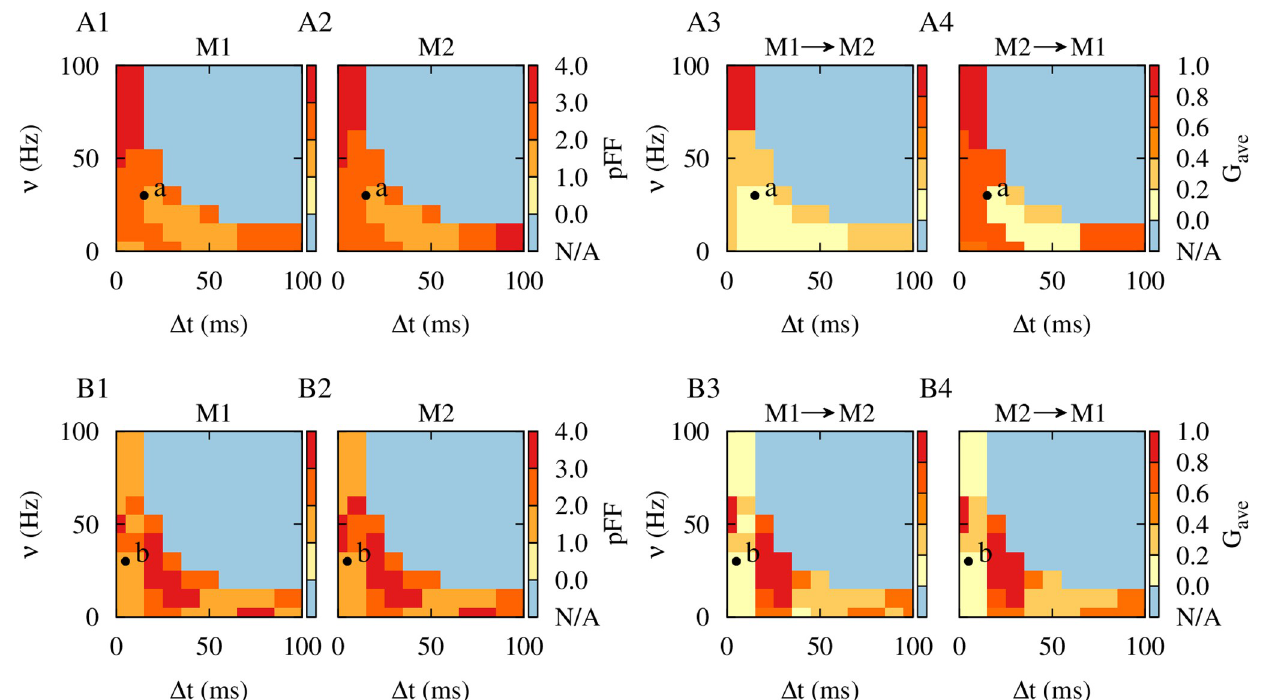
Fig 8. Rescaling the parameters of time-shifted decoupling stimulation. ( A1-A4 ) Synchrony level measured by the pFF of the activity of each module (A1,A2) and the averaged inter-population mean coupling ( G ave ) between the two modules in the network (A3,A4) obtained by numerical simulations for different values of stimulation frequency and time shift with | ξ | = 0.0 ms, evaluated over 10 s of activity after stimulation offset. ( B1-B4 ) Same as A1-A4, but with | ξ | = 10.0 ms. STDP parameters were A + = 0.008, A = 0.005, τ + = 10 ms and τ = 20 ms. Points a and b in the figure indicate the stimulation frequency − − and time shift used in Fig 2A and 2C, respectively. Blue (N/A) region shows the range of parameters where the 0 < Δ t < T = 1/ ν constraint is not satisfied.